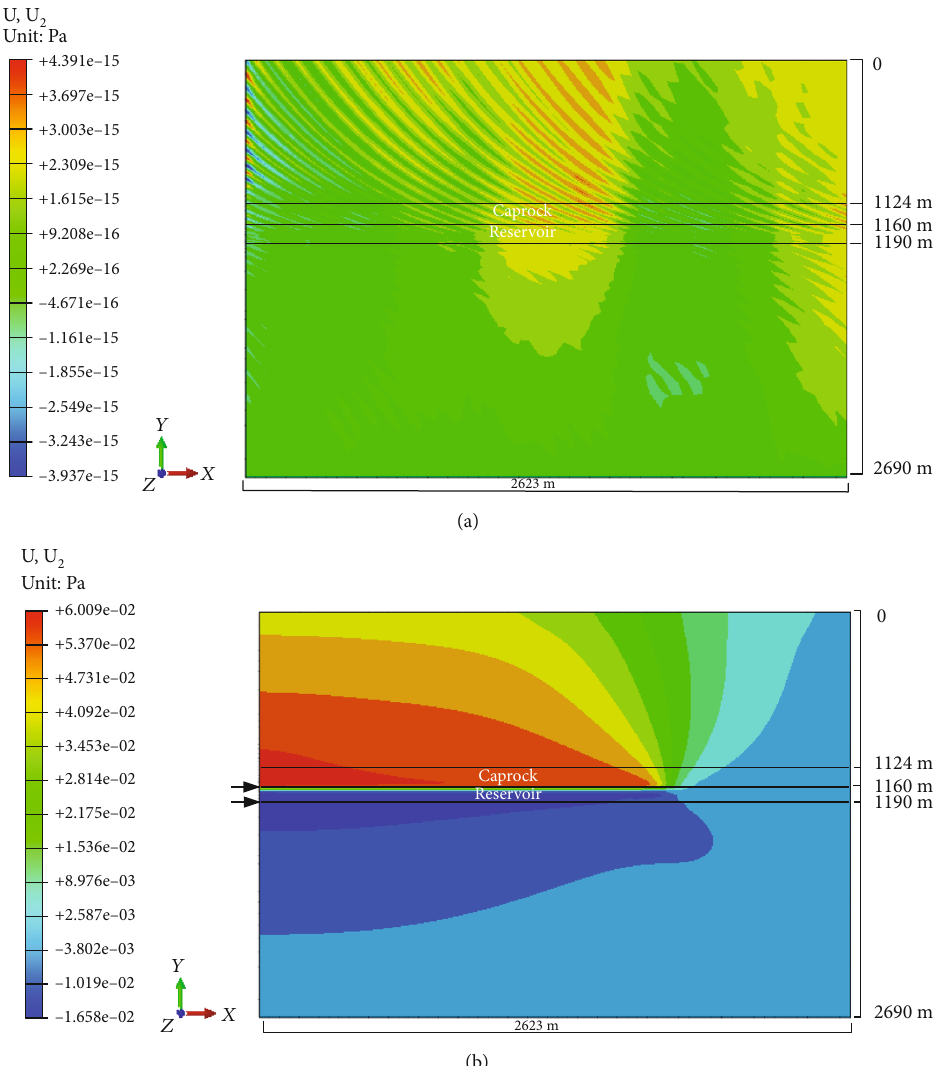
Figure 11: Vertical displacement change nephogram. (a) Before injection. (b) After